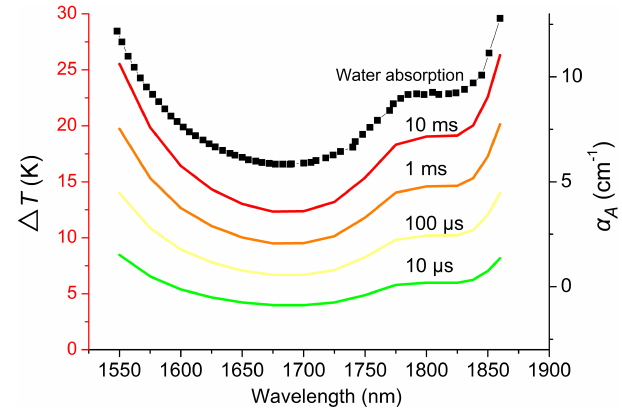
Fig. 3. Temperature rise vs wavelength for di®erent irradia- tion time (left axis). Water absorption coe±cient vs wavelength is also shown for comparison (right axis). The excitation light is 20 mW.